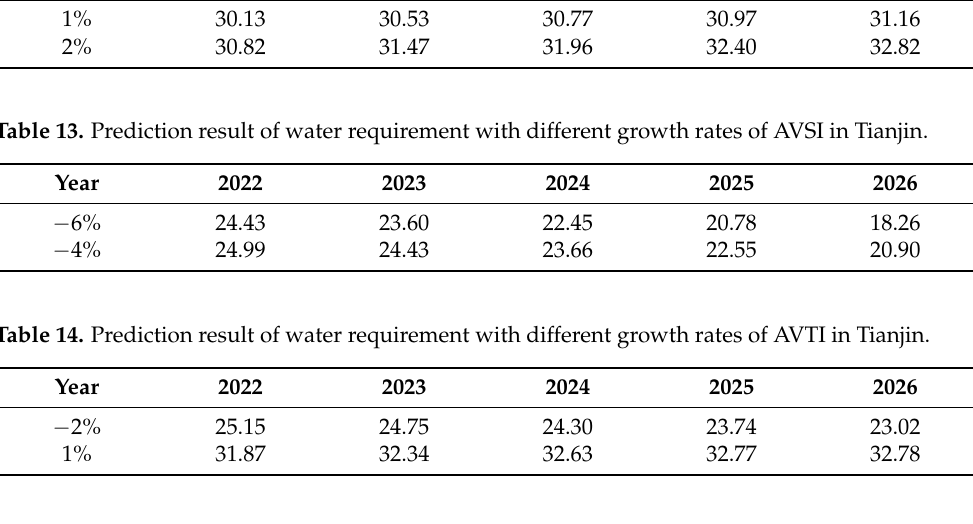
Table 15. Prediction result of water requirement with different growth rates of YEP in Tianjin.